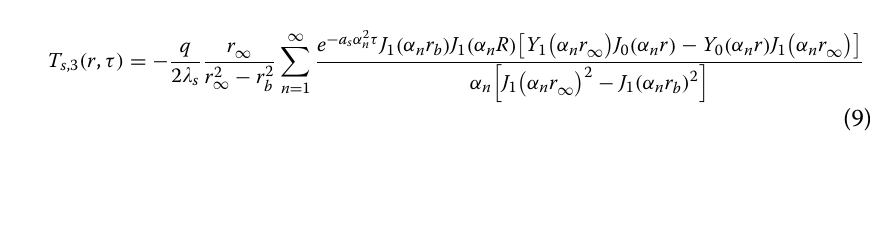
Table 1 Distribution of minimum positive root α 1 of Eq. 6 at different radii of thermal impacted circle r b r ∞ (cid:31)